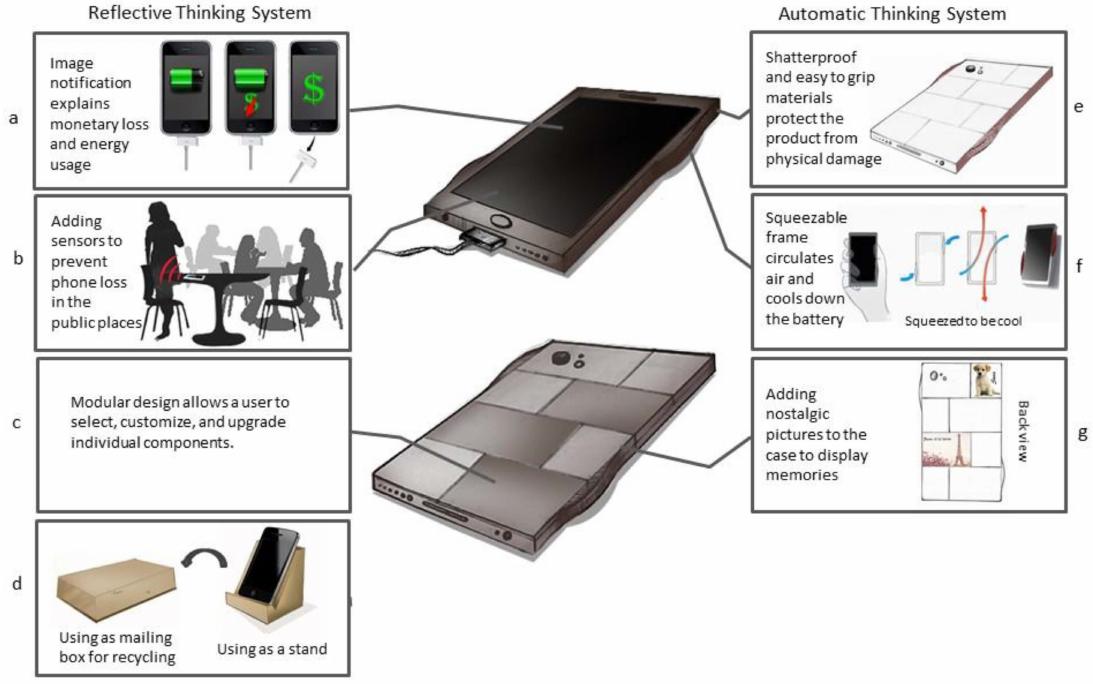
Figure 7. Integrative application of the SBD framework: sustainable smartphone design combines solutions to all four sustainability goals while addressing the reflective ( a–d ) and the automatic ( e–g ) thinking